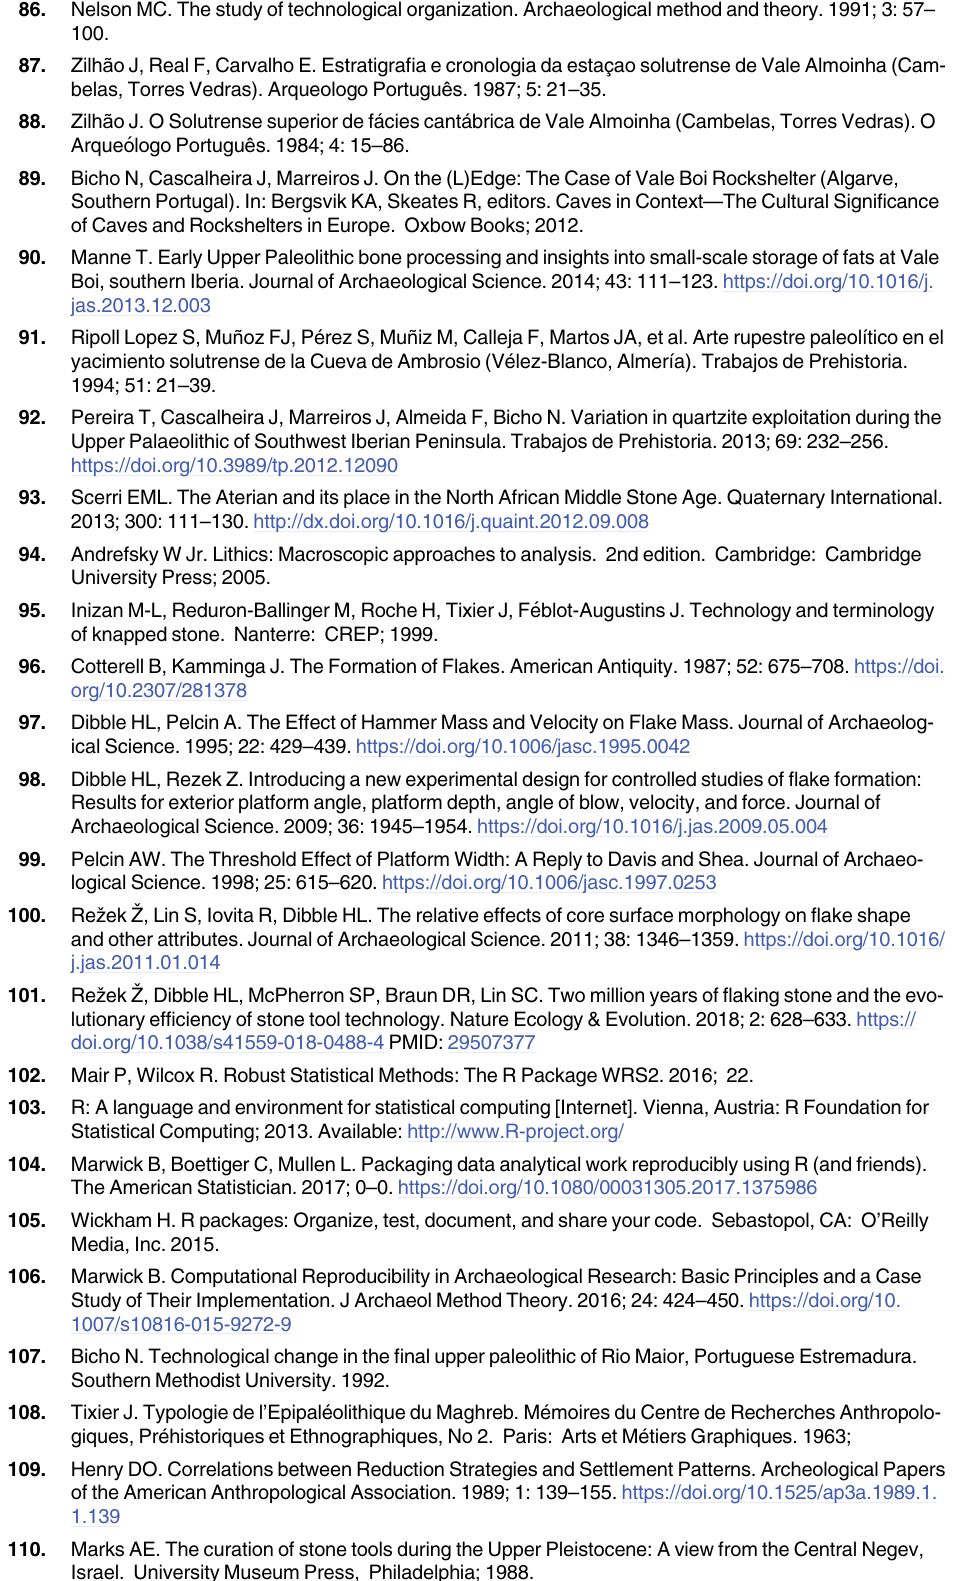
110. Marks AE. The curation of stone tools during the Upper Pleistocene: A view from the Central Negev, Israel. UniversityMuseum Press, Philadelphia;